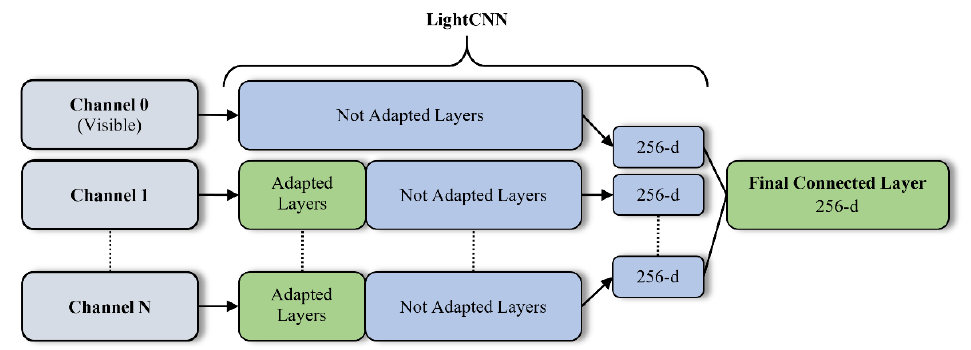
Figure 2. DCNN proposed